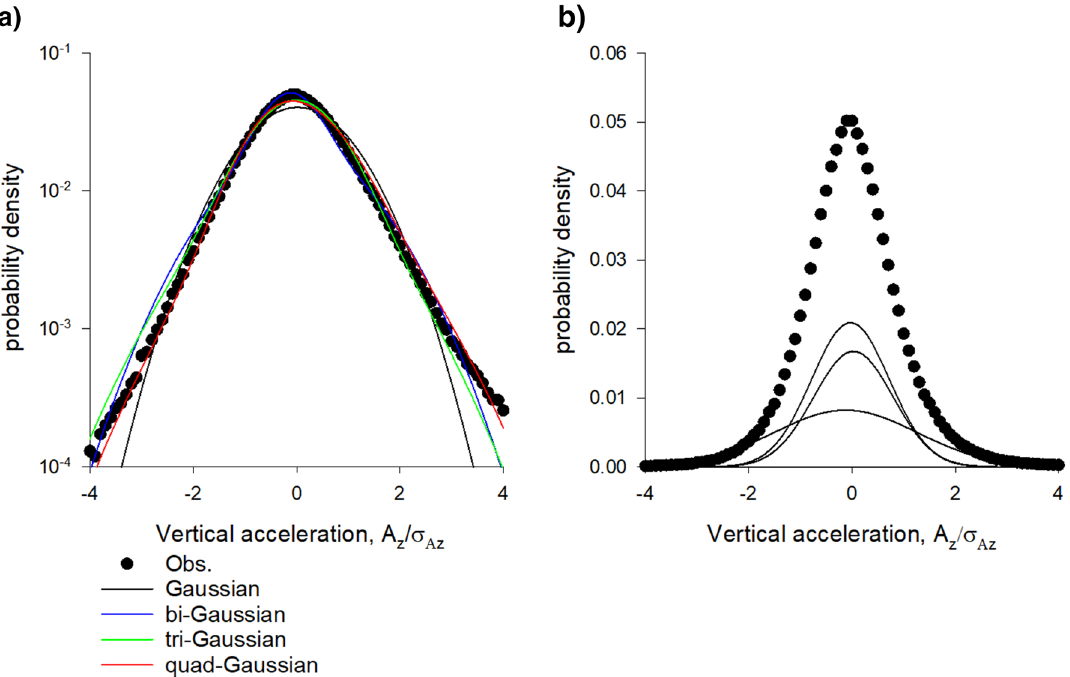
Figure 5. ( a ). Distributions of vertical accelerations are accurately represented by superpositions of Gaussians. ( b ) Constituent Gaussians in the tri-Gaussian representation with centres at •. The Akaike weights for the single-, bi-, tri- and quad-Gaussian fits are 0.00, 0.03, 0.89 and 0.09 indicating strong support for the tri- Gaussian representation. Data are taken from Sinhuber et al. 14 : swarm Ob1 which contains on average 94 individuals.